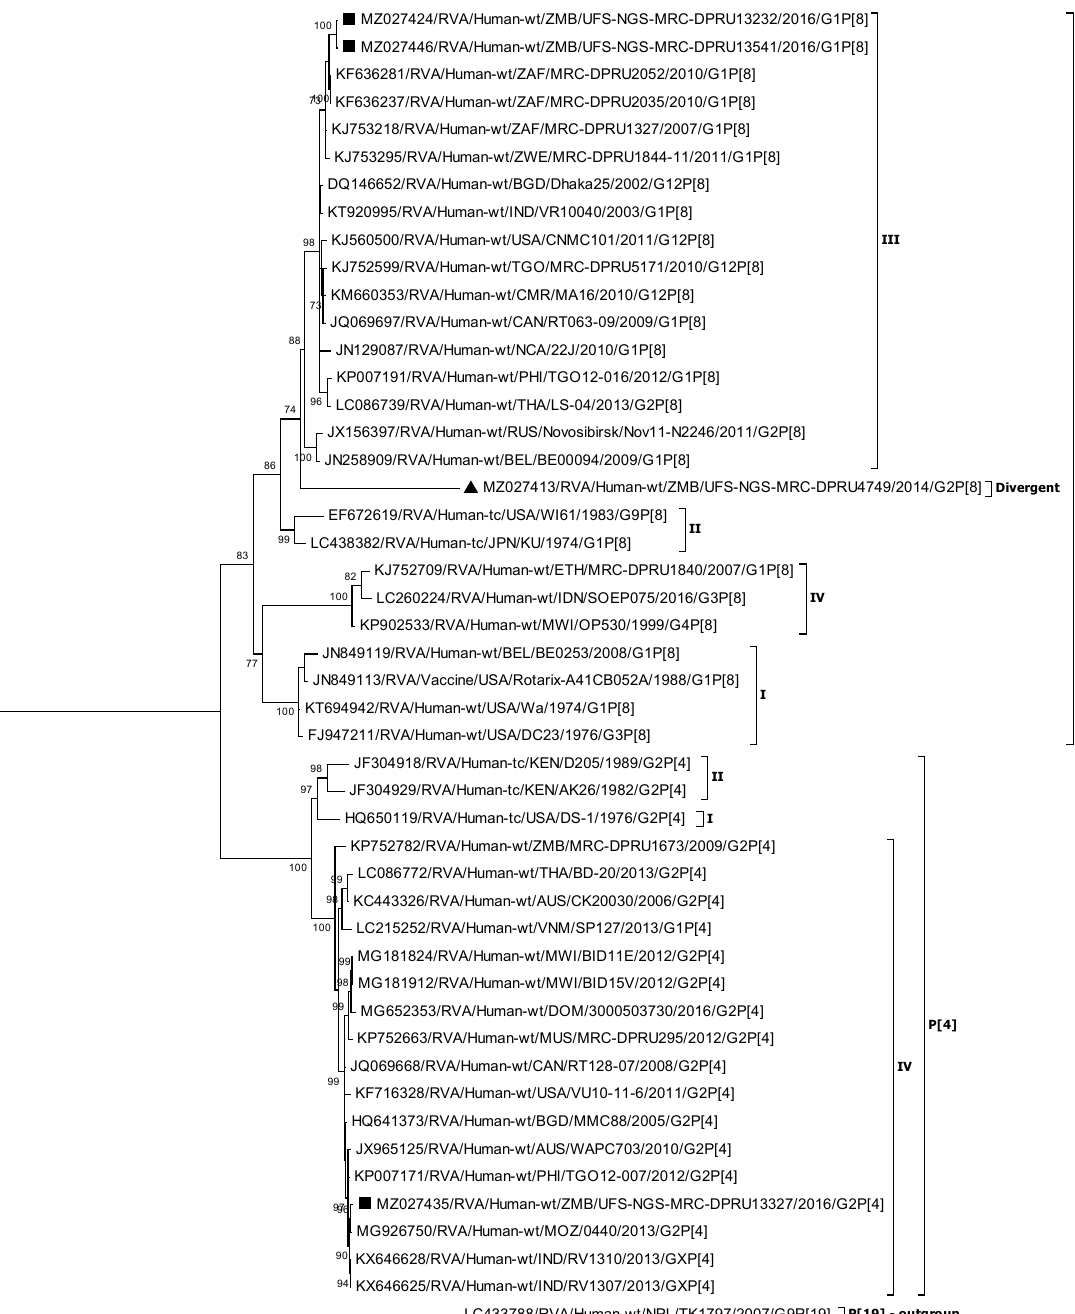
Figure 2. VP4 phylogenetic tree of the Zambian P[4] and P[8] strains indicated by black squares along with representative strains. Strain UFS-NGS-MRC-DPRU4749, indicated by a black triangle, is a divergent strain. Phylogenetic analysis was conducted using the maximum likelihood method with bootstrap values of 1000 replicates. The scale at the bottom indicates the number of nucleotide substitutions per site. Percent values of bootstrap values greater than or equal to 70 is indicated on the branch nodes.